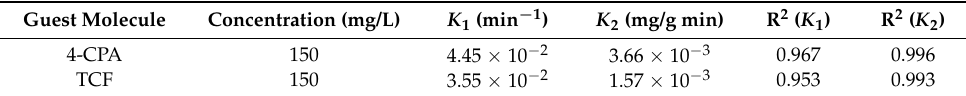
Table 6. Values obtained for K1 and K2.